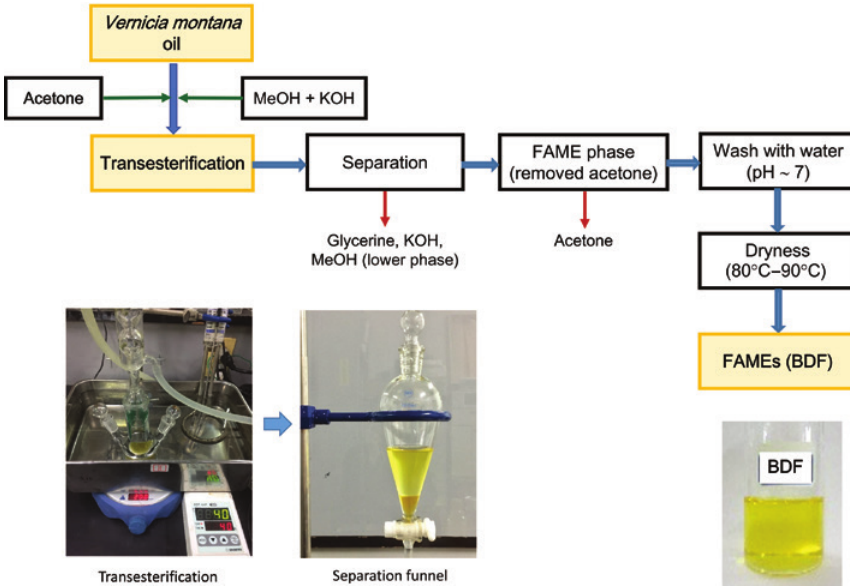
Figure 1: Flow diagram of BDF production from VMO using a co-solvent